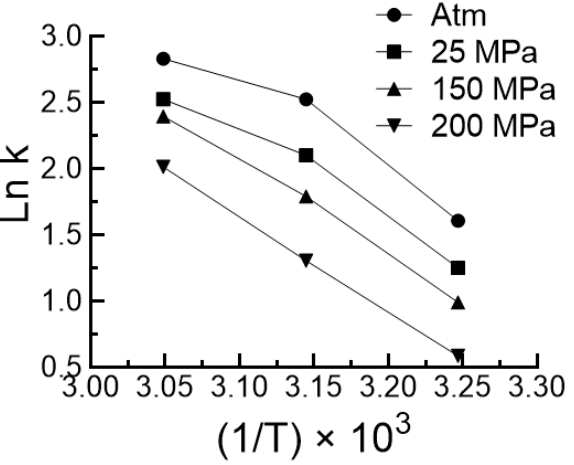
Figure 8. Arrhenius plots of the autocleavage reaction of ASBVd(–) at different pressures.